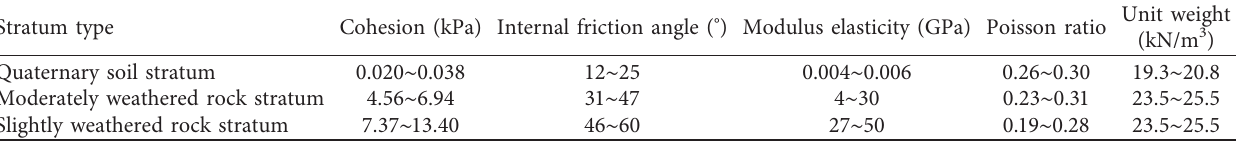
Table 9: Statistical analysis of strata physical and mechanical parameters.